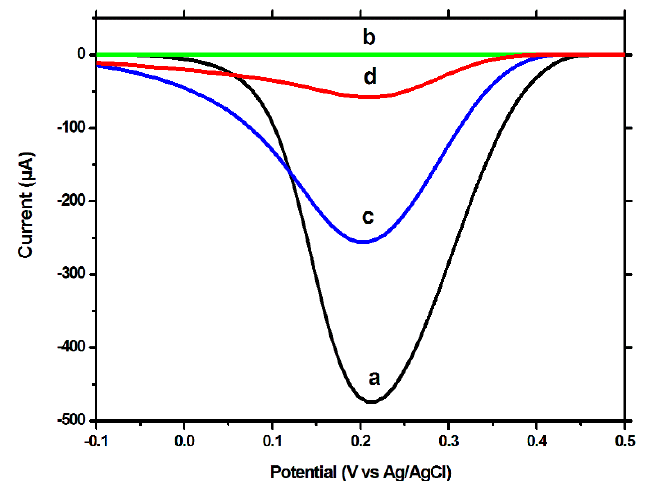
Figure 3. DPV voltammograms on the BDDE in 10 mM [Fe(CN) 6 ] 3 − , in 0.02 M PBS on: ( a ) the unmodified electrode, ( b ) after electropolymerization, ( c ) after template removal (incubation for 30 min, under stirring, in NaOH 0.1 M solution) and ( d ) after rebinding of CFX (incubation for 30 min, under stirring, in 1 µM CFX solution).PH − 100 mV, PW 50 ms, SR 20 mV/s.